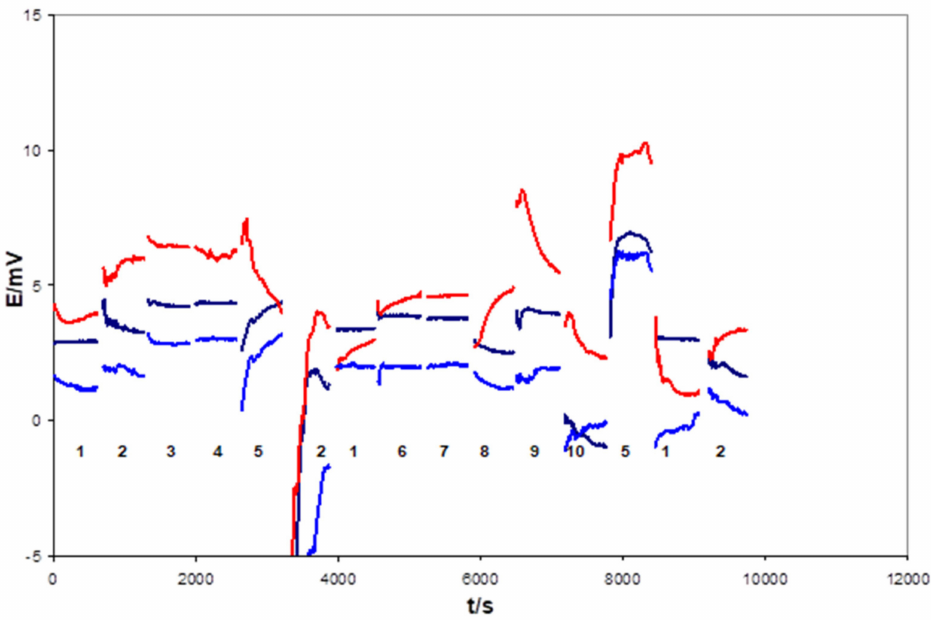
Figure 5. Potential changes of the 1e type electrodes recorded during multi-solution testing subsequently in indicated solution: 1—3 M KCl, 2—H 2 O, 3—0.01 M NaCl, 4—0.01 M KCl, 5—0.01 M HCl, 6—0.1 M NaCl, 7—0.1 M KCl, 8—0.1 M NaBr, 9—0.1 M NaHCO 3 , 10—0.001 M KOH. The mean potential values for these electrodes were equal to 3.17 ± 1.65 mV, 4.59 ± 2.03 mV, and 1.67 ± 1.69